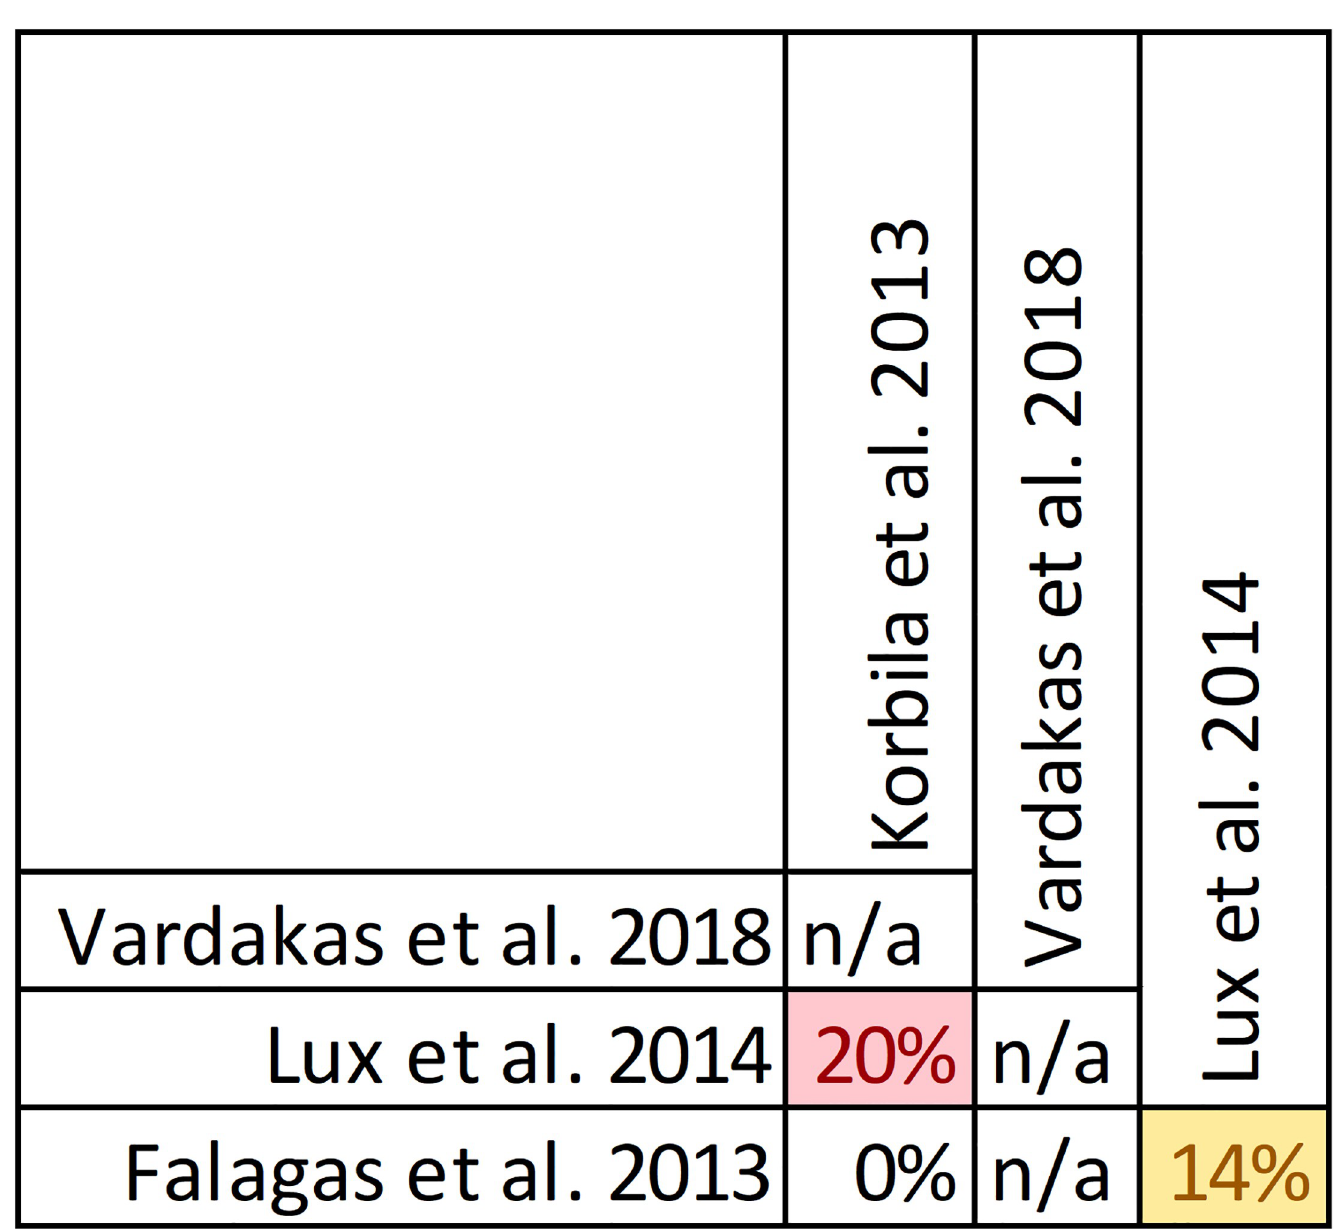
Fig 19. Pairwise CCA for reviews reporting emergence of resistance of prolonged versus intermittent infusion of beta-lactams. Colors indicate degree of overlap, as calculated with CCA, for visual clarity. White = � 5%, green 5.1–9.9%, yellow 10–14.9%, red � 15%. N/A indicated where primary studies included were not reported by systematic